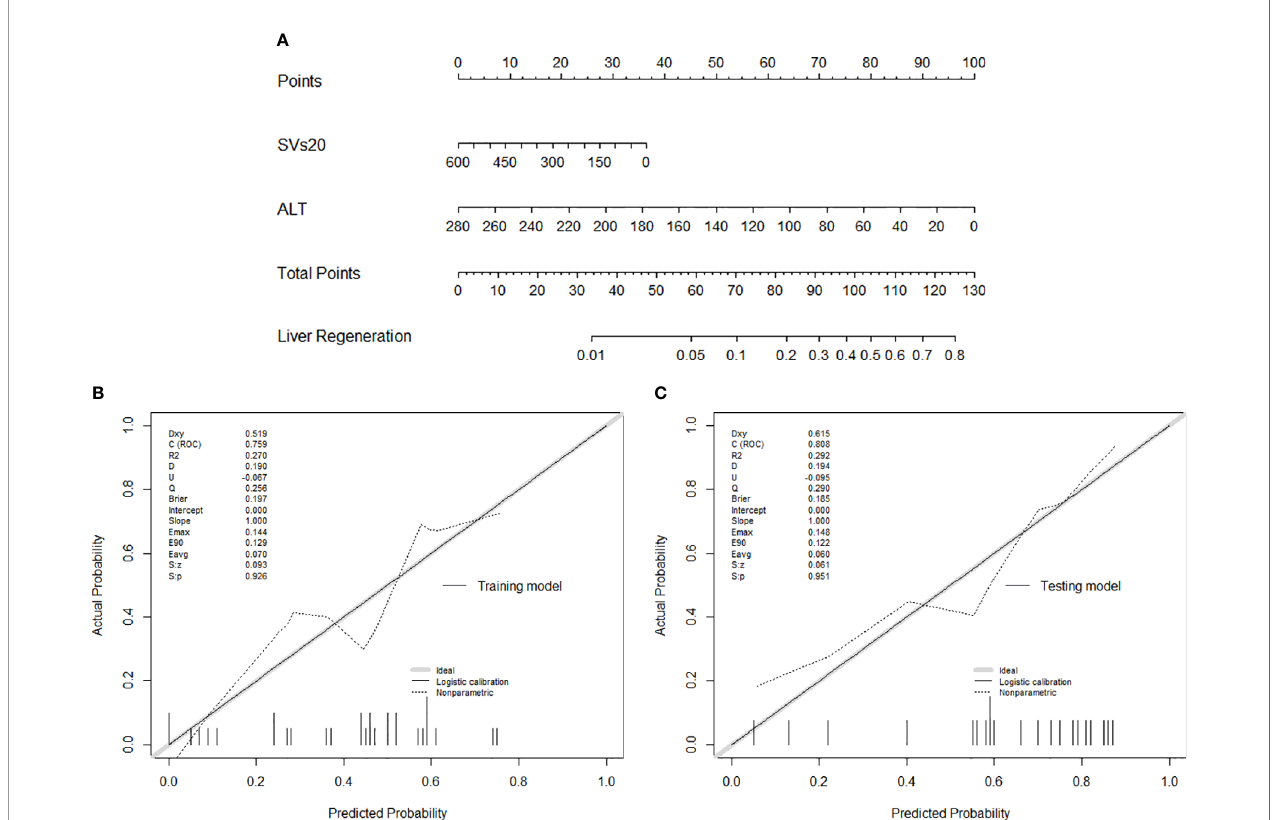
FIGURE 4 | (A) Nomogram of liver regeneration based on SVs20 and ALT; (B) The calibration curve in the training cohort; (C) The calibration curve in the testing